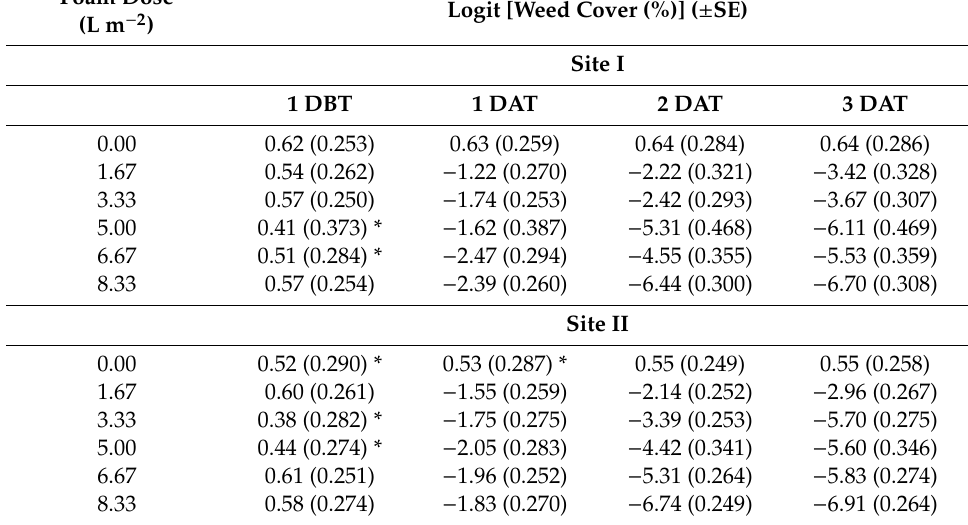
Table 4. Least squares means and standard errors (SE) of weed cover percentage logit transformed as a ff ected by the foam dose, the site and the evaluation date (one day before and one, two and three days after treatments) in the Taraxacum o ffi cinale (Weber) and Plantago lanceolata (L.) infested field experiment. Foam